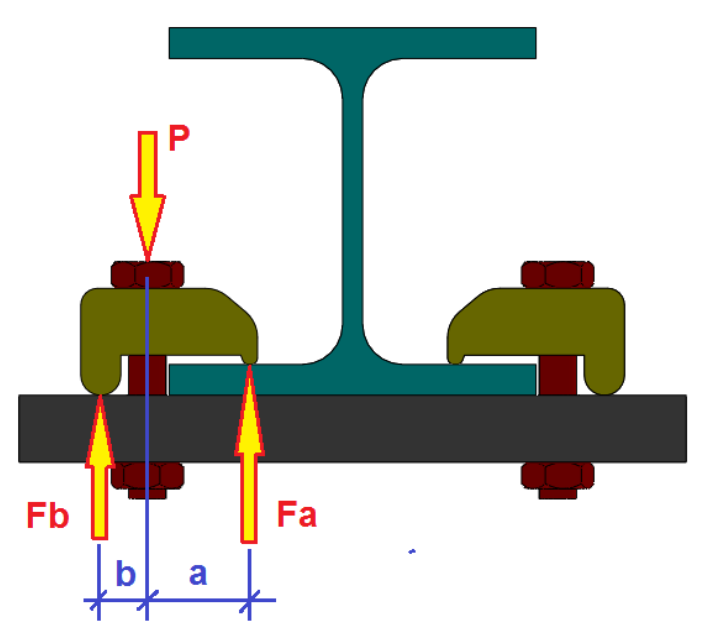
Figure 2. Force diagram of the operation of a clamped joint. When a joint is not fully rigid, and a bending moment is applied to the joint, the relative angle between the connected members ( β ) that form the joint (Figure 3) varies ( ϕ Ed ). This variation affects the joint’s moment rotation diagram, thereby causing a variation of the joint’s bending moment absorption capacity and a variation of the structure’s stiffness compared to when the joints are fully rigid.